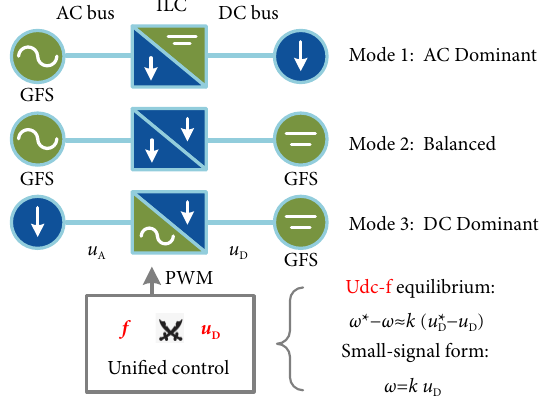
Fig. 1 Unified controls for the ILC in multiple operation modes of a hybrid